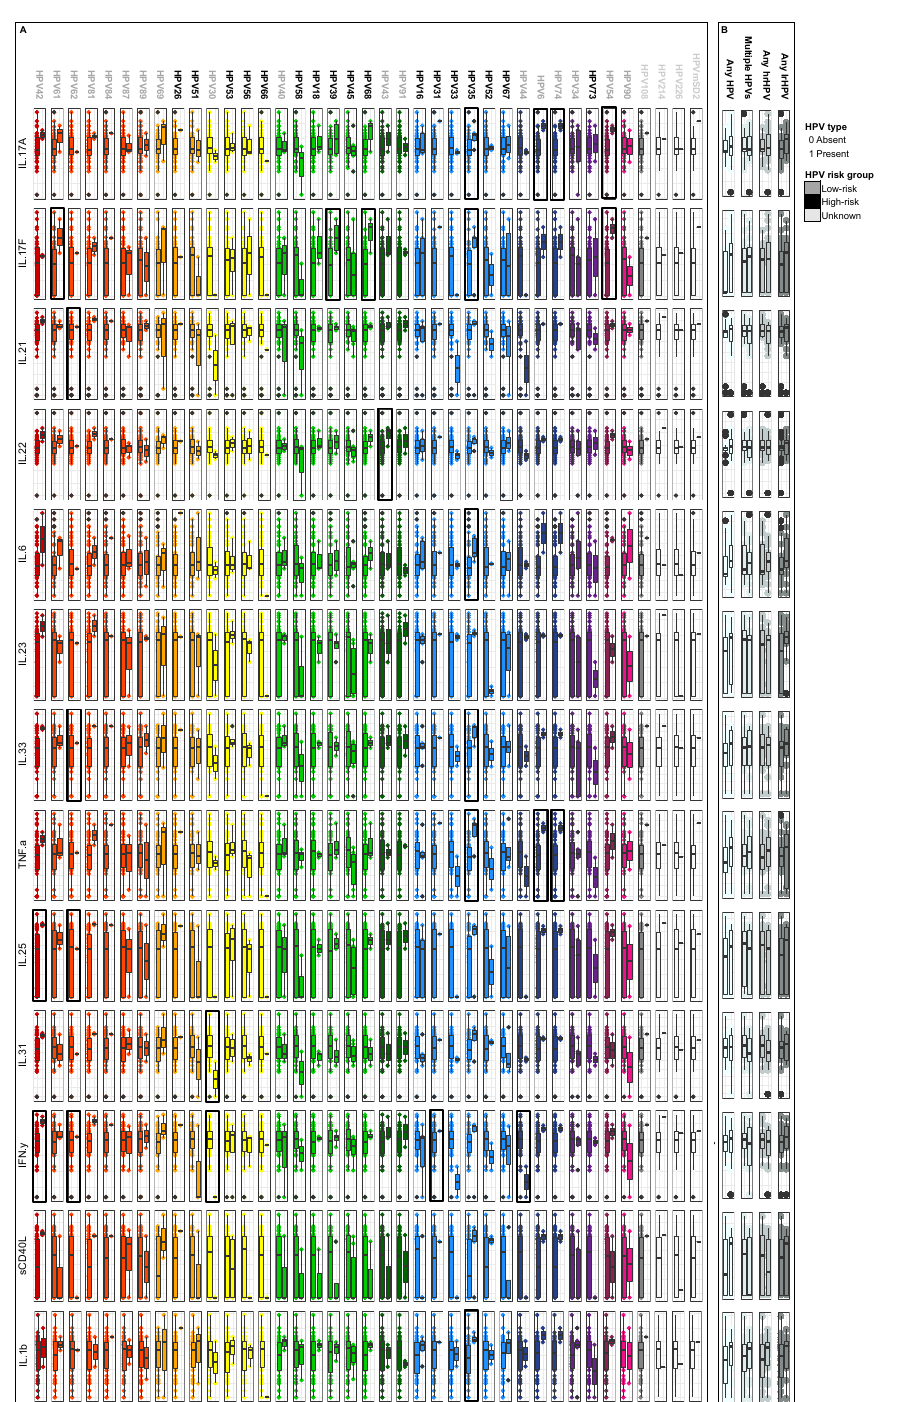
Figure 6. Associations between cervicovaginal cytokines and presence of HPV genotypes. ( A ) In a univariate analysis, the measured concentrations of cytokines were compared in samples of women with a given HPV genotype (labelled 1) to that of samples from women without the given HPV genotype (labelled 0). Significant differences are highlighted using a black box. ( B ) The same comparisons were made for samples from women with any HPV genotype present versus those without, and those with multiple HPV genotypes, any high ‐ (hr) or any low ‐ risk (lr) HPV genotypes. This analysis includes samples from the 33 women included in the viral metagenome sequencing project.